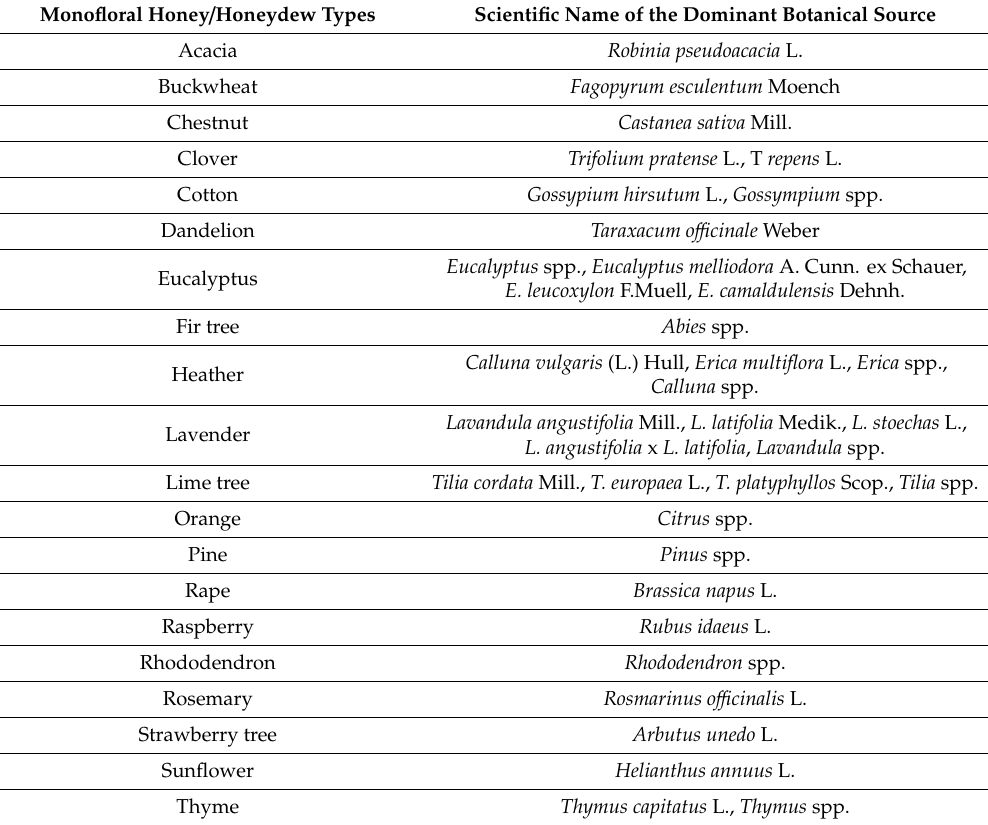
Table 1. List of monofloral honey / honeydew types selected for volatile’s composition comparison. Common names are ordered alphabetically according to their main botanical